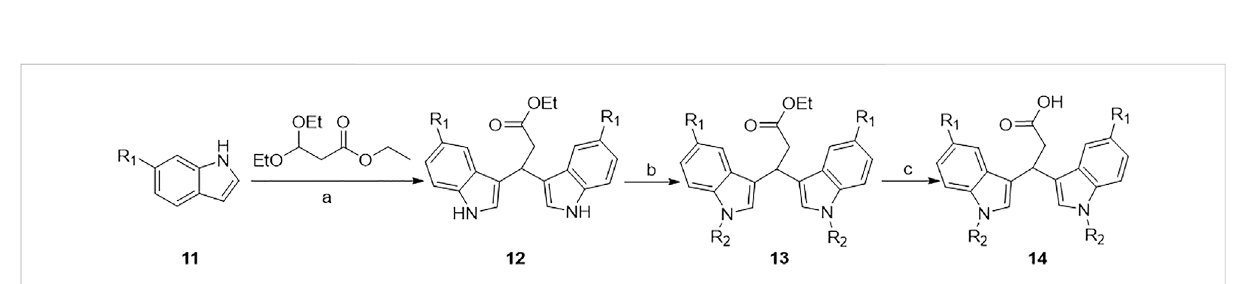
FIGURE 4 Synthetic route of 3,3-diindolepropionic acid derivatives. Reagents and conditions: a) CH 3 COOH, KHSO 4 ， 80 ° C, 5 h; b) KOH, R-X, THF, r.t.; c) LiOH, CH 3 OH: H 2 O = 1:1 (v/v), 75 ° C, 2 h, 2 M